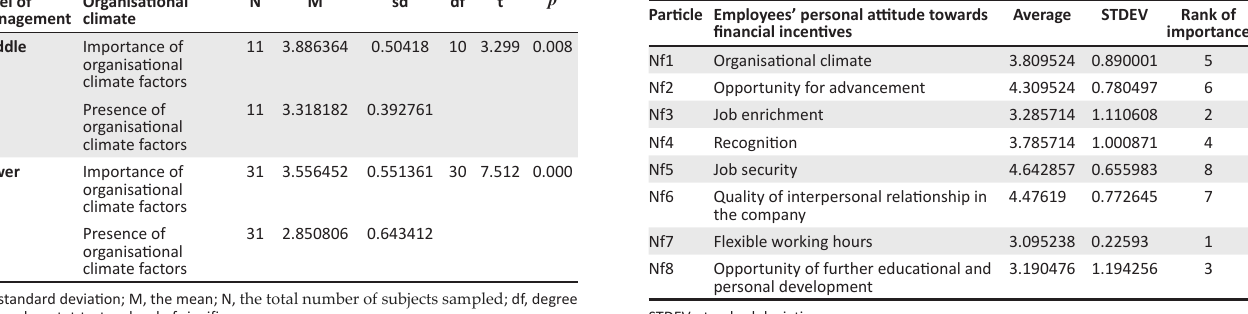
Table 7: Personal attitudes of the staff to the importance of non-financial